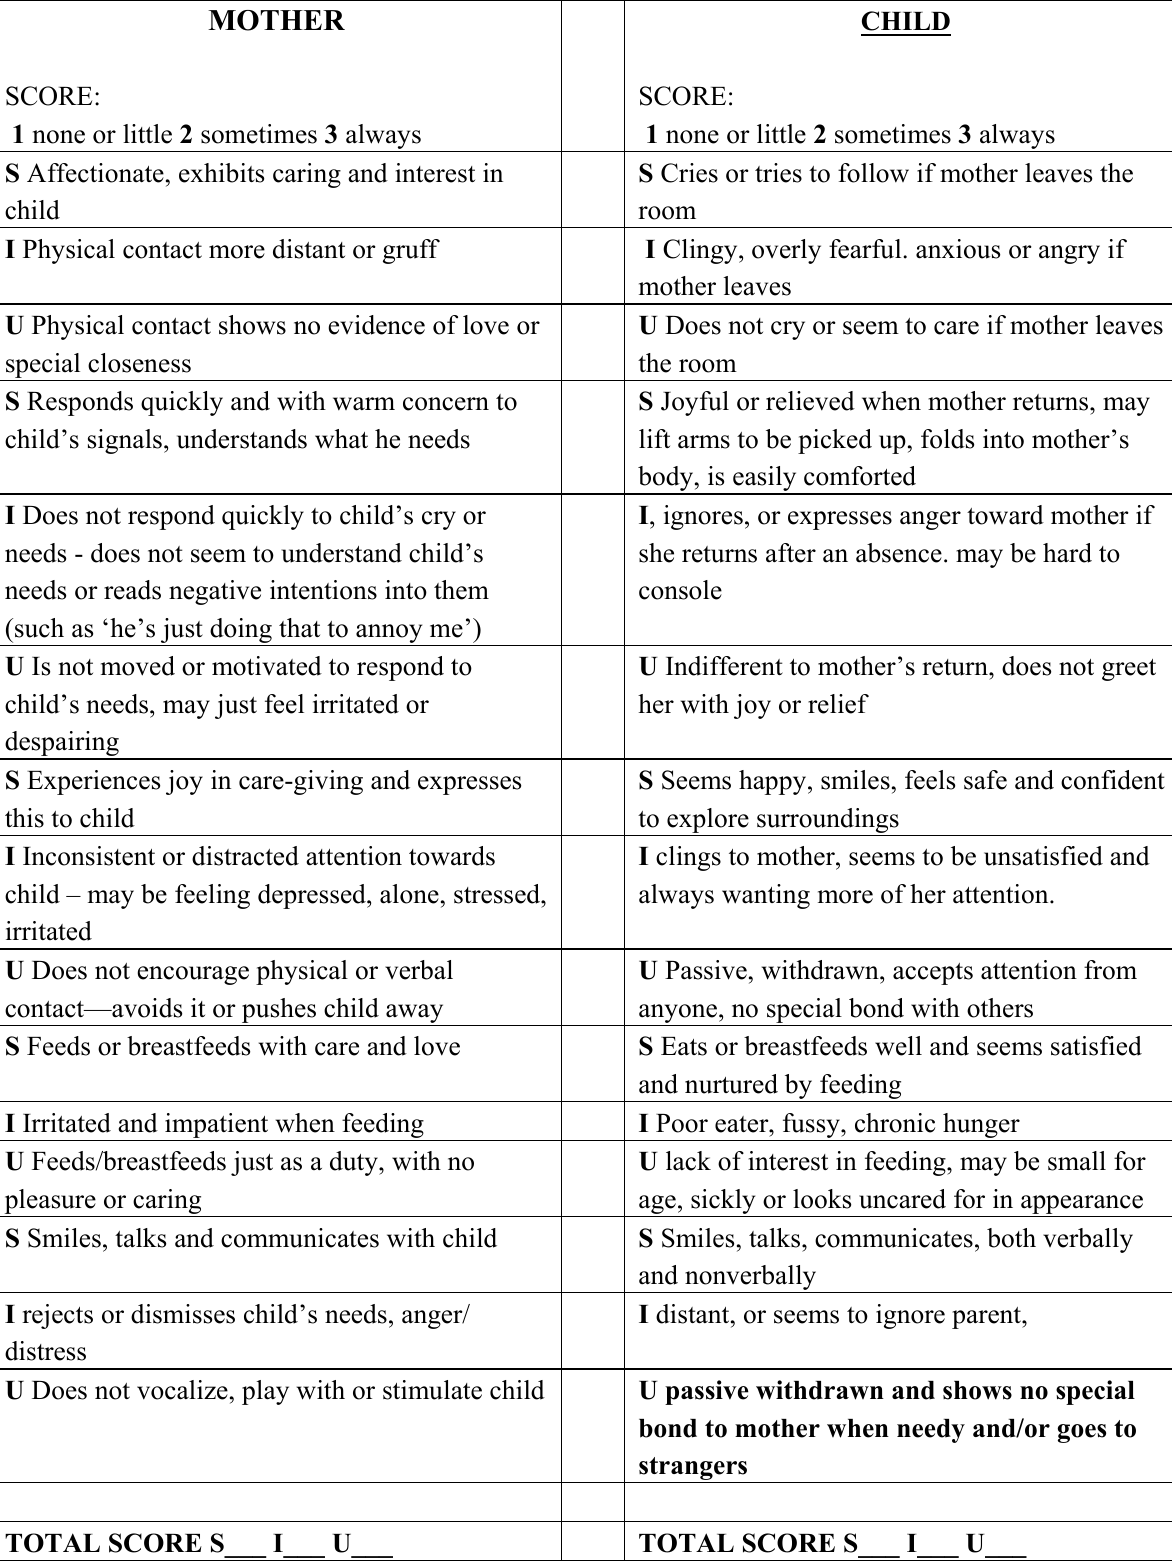
Figure 1. Attachment Assessment Score Sheet, derived from the African version of the Circle of Security ( © Robert Marvin